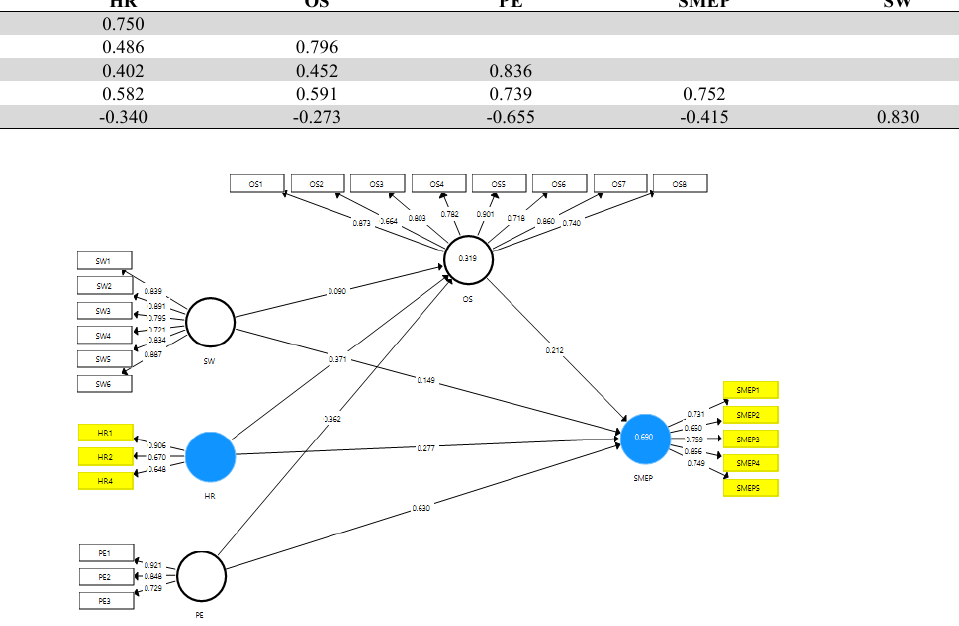
Fig. 3. Measurement Model